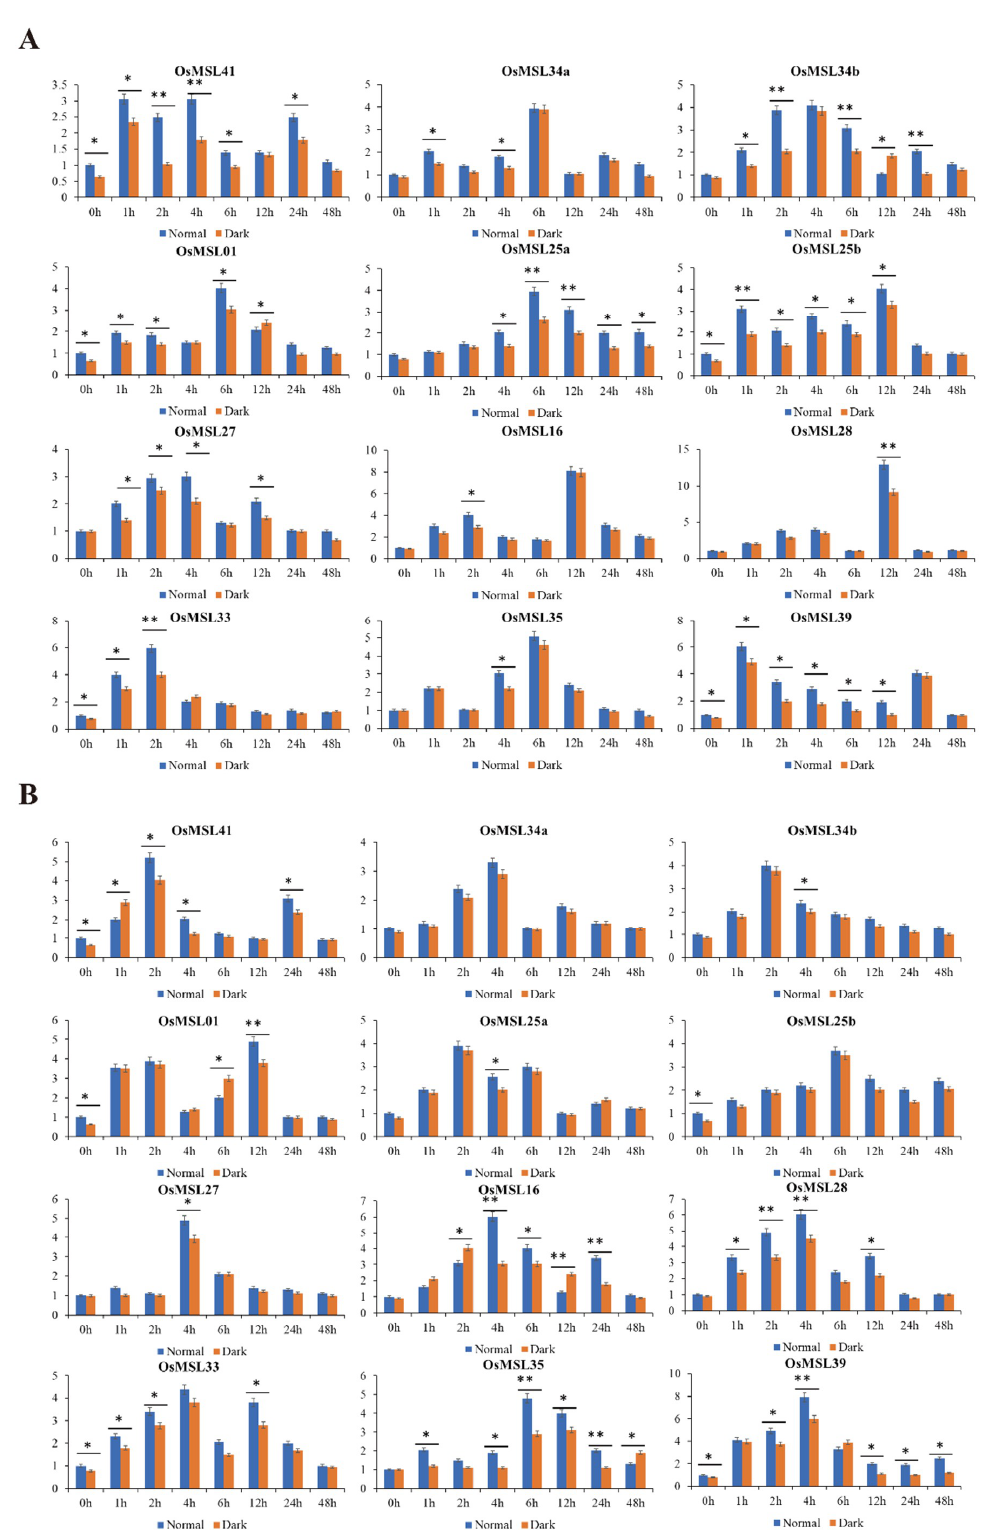
Figure 11. Expression profiles of 12 selected OsMSLs in response to ( A ) drought, ( B ) high salt stress, treatments. Data were normalized to the β -actin gene. Vertical bars indicate standard deviations. Asterisks indicate corresponding genes significantly upregulated or downregulated compared with the control. (* p < 0.05; ** p < 0.01; Student’s t